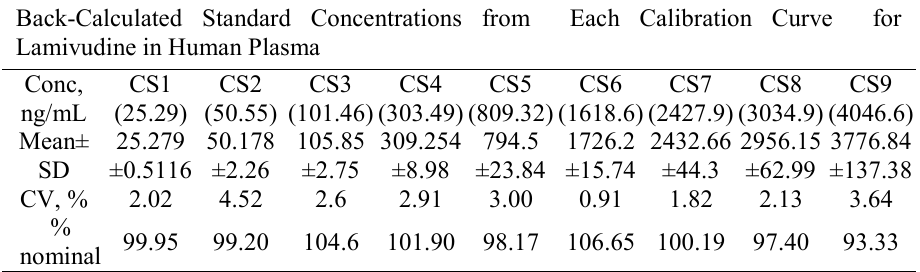
Table 2. Back-Calculated Standard Concentrations for LAM and ZID in human plasma. Back-Calculated Standard Concentrations from Each Calibration